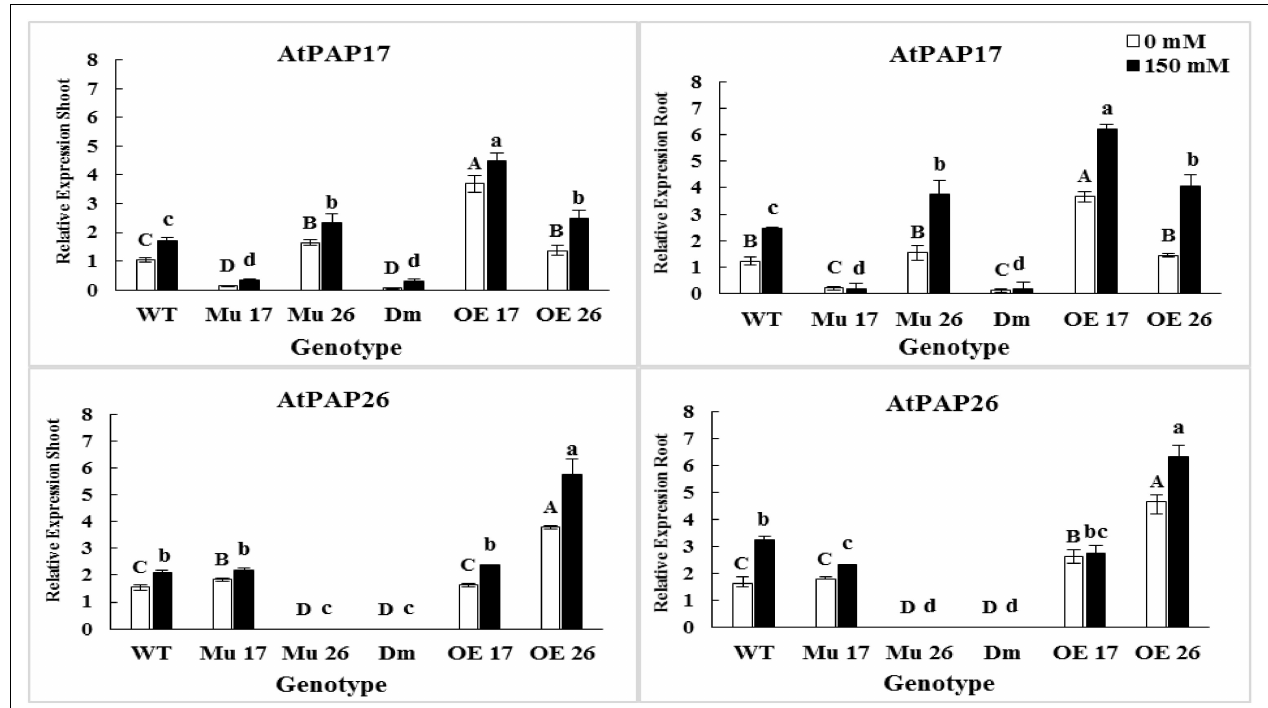
FIGURE 5 | The expression level of AtPAP17 and AtPAP26 genes in shoots and roots of genotypes subjected to 150 mM NaCl stress compared to no NaCl stress. Wild-type (WT), overexpress (OE), single mutant (Mu), and double mutant (DM) genotypes of Arabidopsis thaliana purple acid phosphatase 17 ( AtPAP17 ) and 26 ( AtPAP26 ) genes. The significant mean differences ( P < 0.05) were separately shown at 0 and 150 mM NaCl concentrations with different uppercase and lowercase letters,